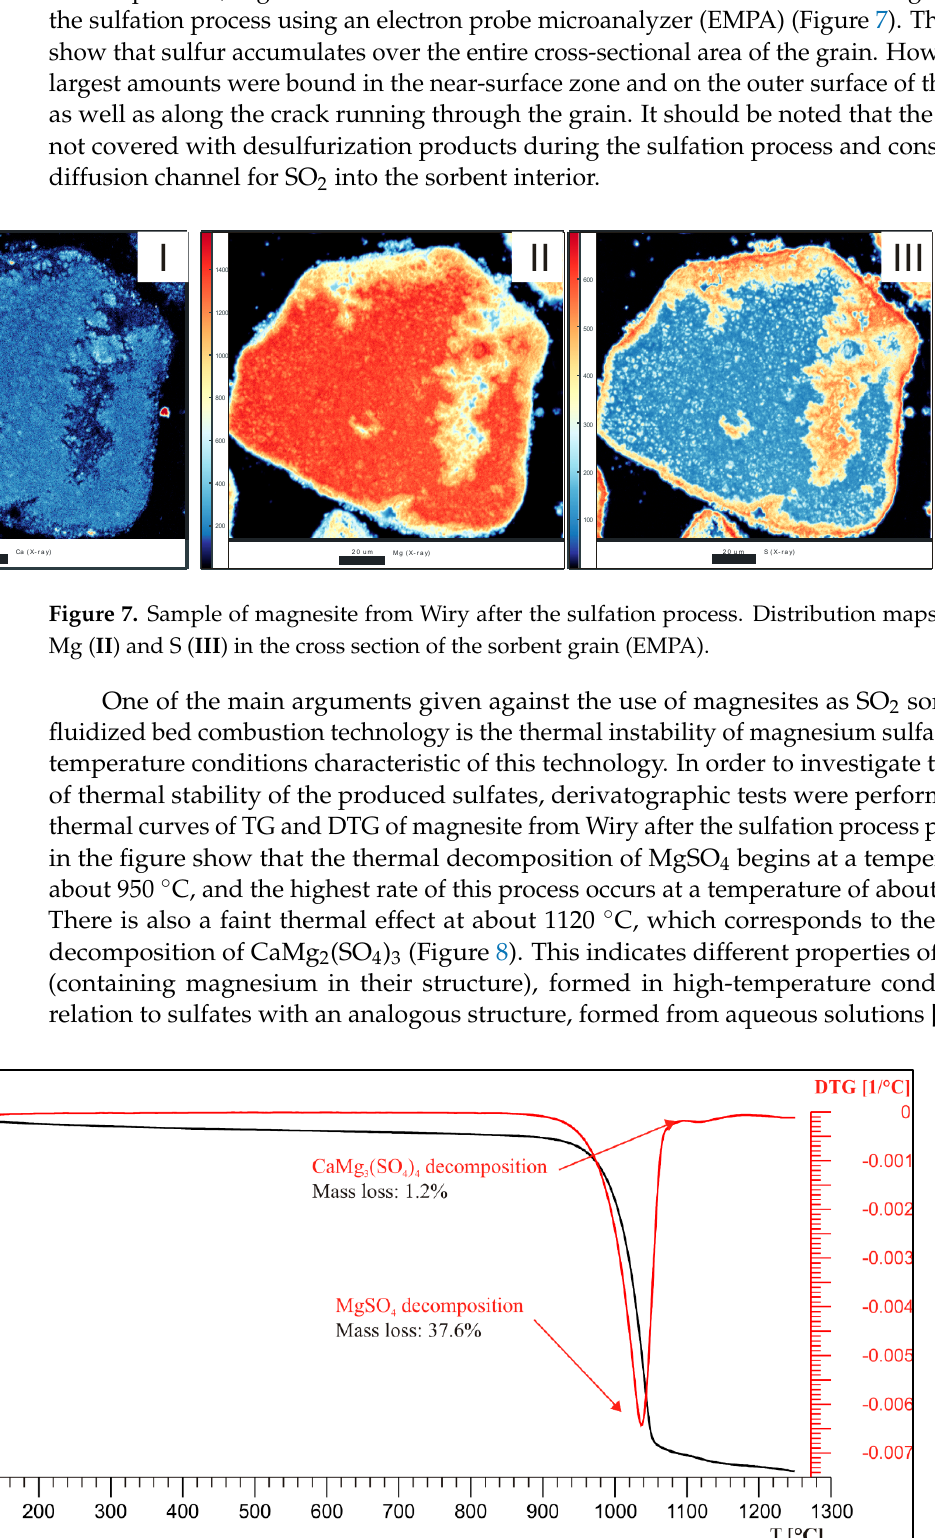
Figure 6. Phase compositions of the Wiry deposit: ( A ) after the decarbonization process (–); ( B ) after the sulfation process (–). Explanations: Qz—quartz (SiO 2 ); P—periclase (MgO); L—lime (CaO); SH— magnesium sulfate hydrate (MgSO 4 · H 2 O); S—magnesium sulfate (MgSO 4 ); CMS—calcium magne-